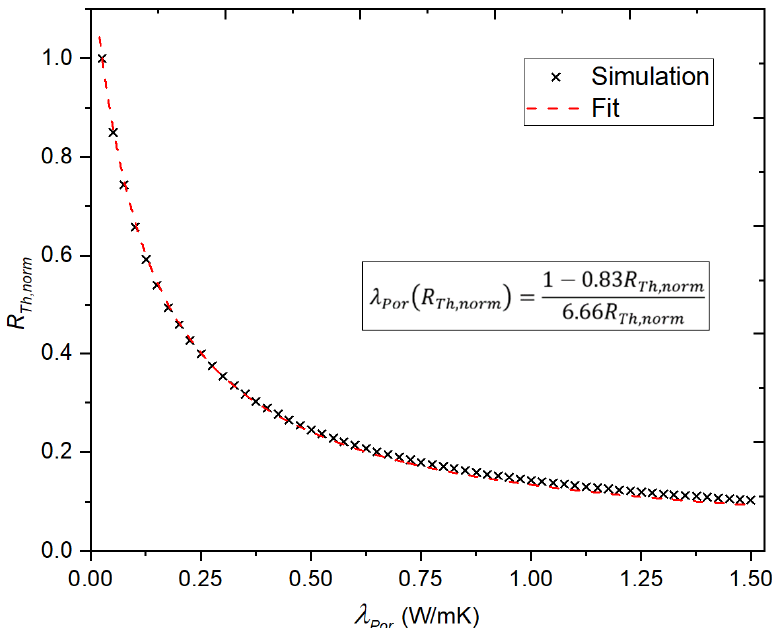
Figure 11. Fit of the thermal model (Equation (5)) to the normalized results of a sweep of λ Por in the interval [ 0.026,1.5 ] . The fitted parameters were found to be K = 0.83 m and G Por = 6.66 m at R 2 = 0.99 .